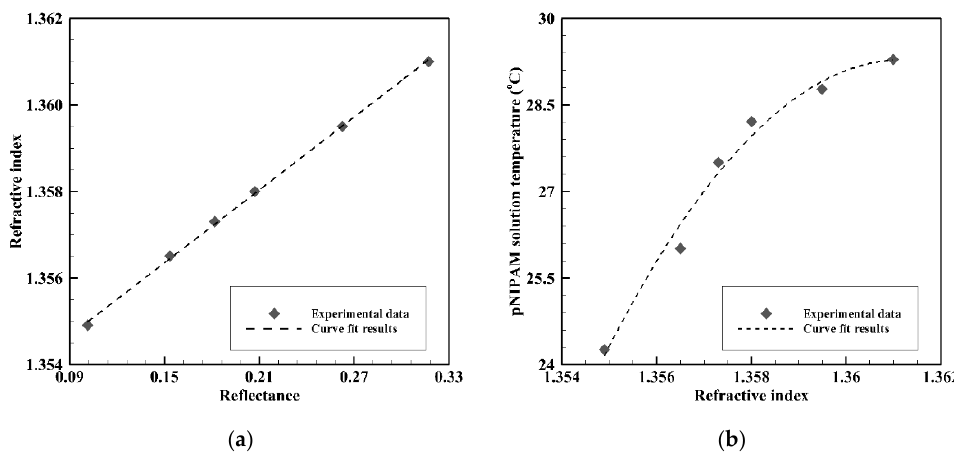
Figure 3. ( a ) Refractive index variation of pNIPAM solution with the reflectance, ( b ) temperature variation according to the refractive index of pNIPAM solution.